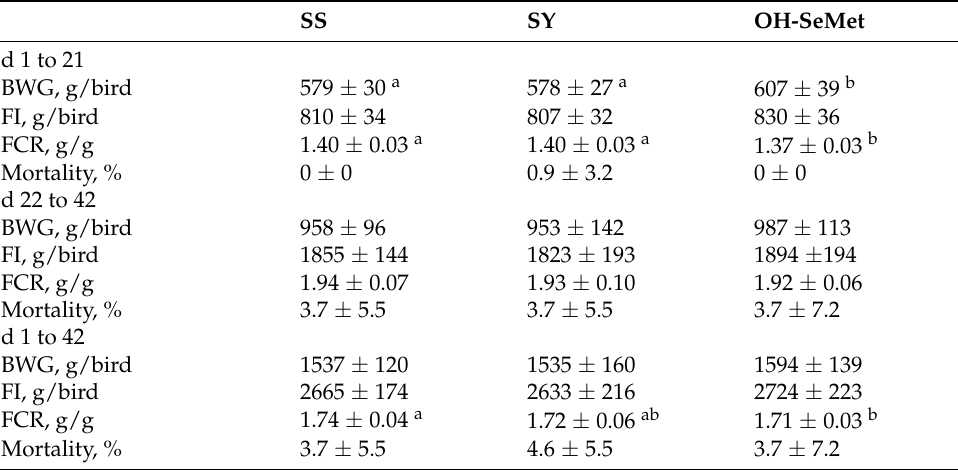
Table 1. Effect of the three selenium forms on the growth performances of the chicks 1 .